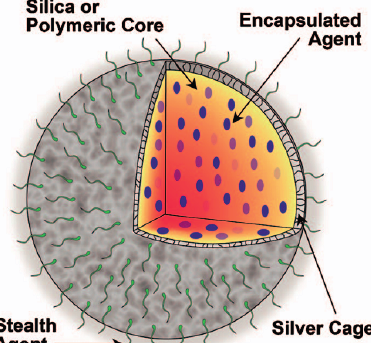
Figure 3. Multifunctional nanosystem platform capable of providing imaging contrast, drug delivery, and image-guided therapy. (Reprinted from reference [39]. Copyright with permission from © 2010 Society of Photo-Optical Instrumentation